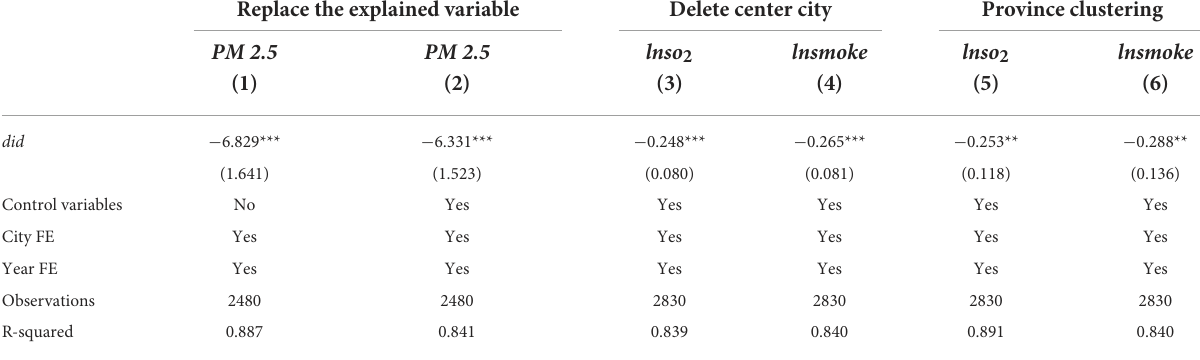
TABLE 4 The results of the robustness